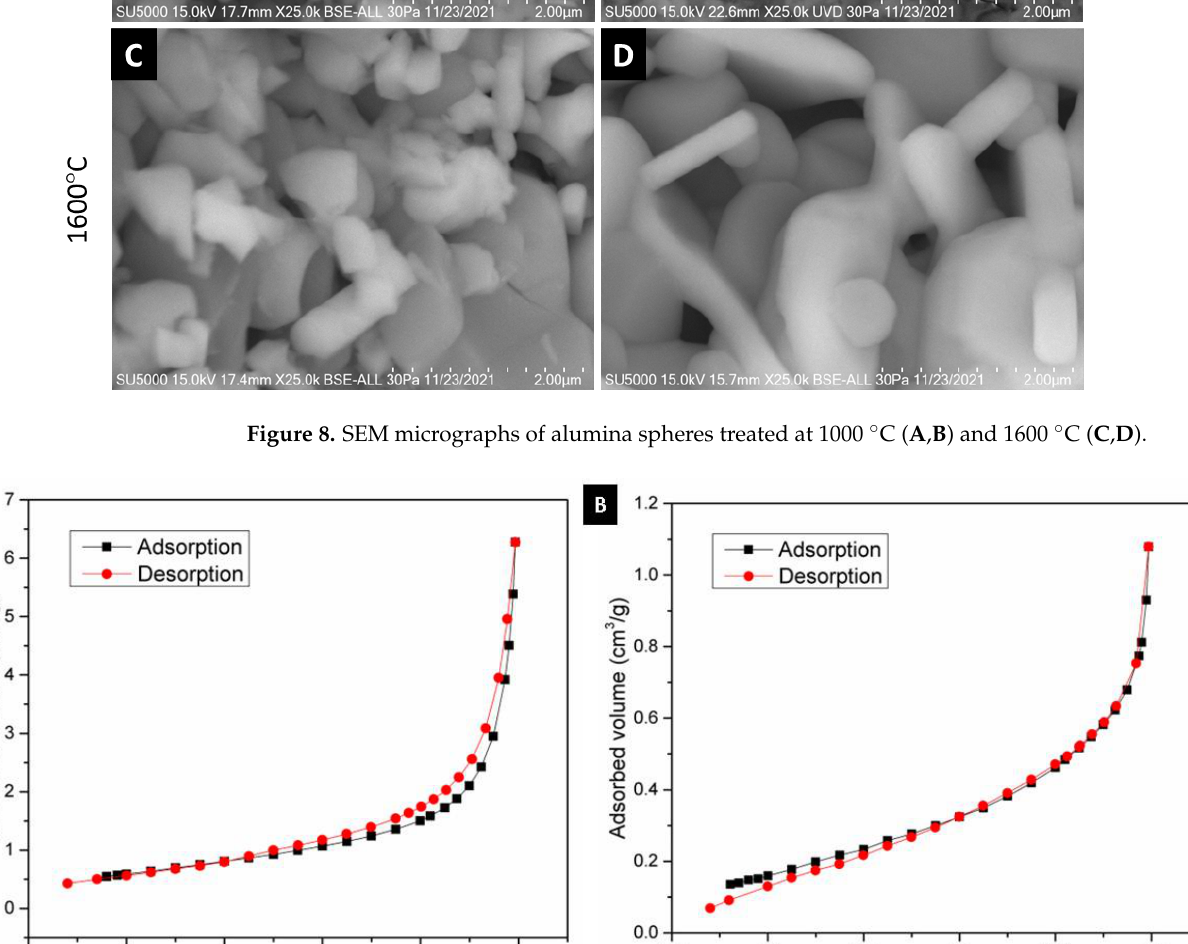
mina sphere at 1600 °C. sphere at 1600 ◦ C.